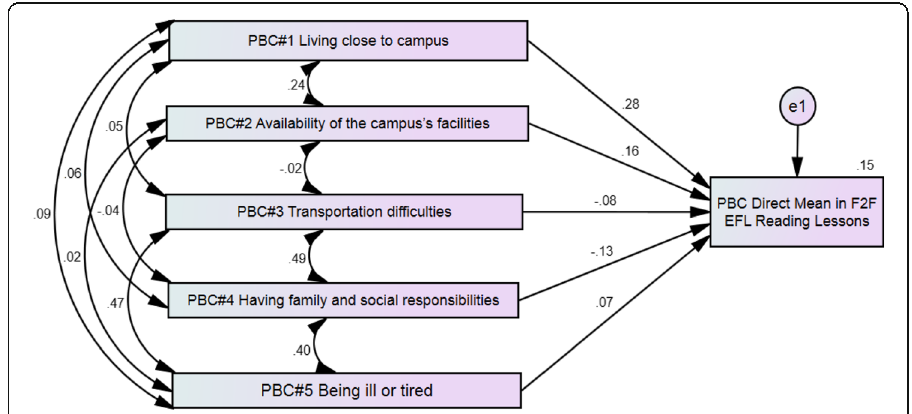
Fig. 1 Diagram of PBC indirect measures for the FLL